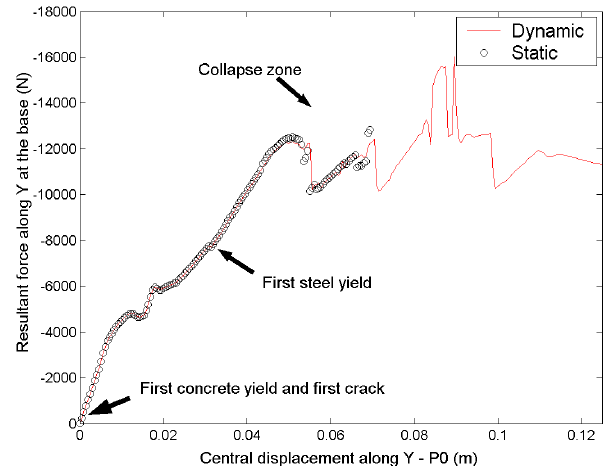
Fig. 12. Pushover test (imposed displacement) for 0.4% steel den- sity inside the concrete. Force-displacement curve obtained in quasi-static and dynamic